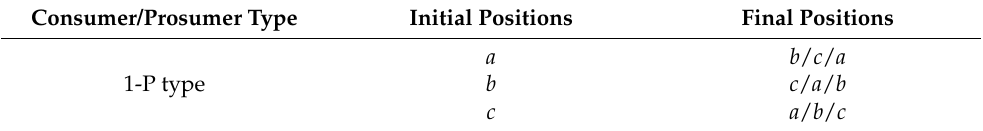
Table 2. The admissible solutions associated with the phase swapping of the consumer/prosumers.